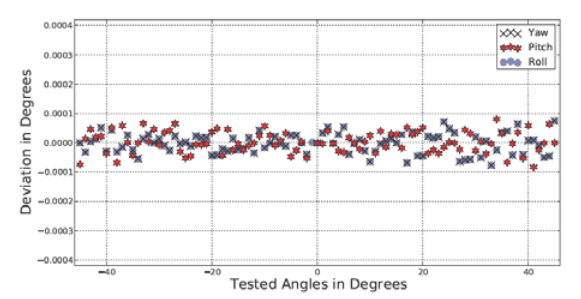
Figure 1. Difference between PHC-calculated relative angles and original, simulated angles varying from -45° to 45°.